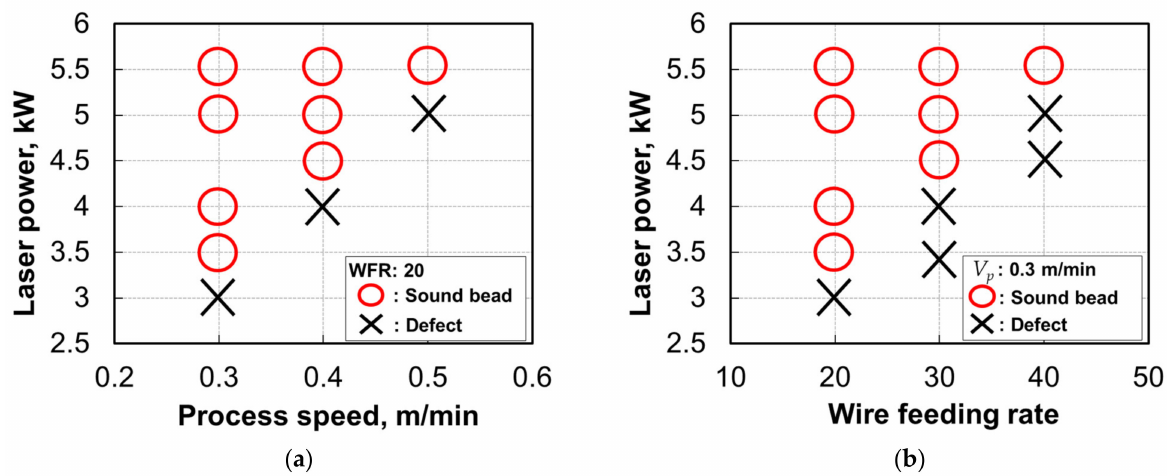
Figure 7. Process windows of bead appearance evaluation for process parameter combinations of ( a ) laser power and process speed and ( b ) laser power and the wire feeding rate.